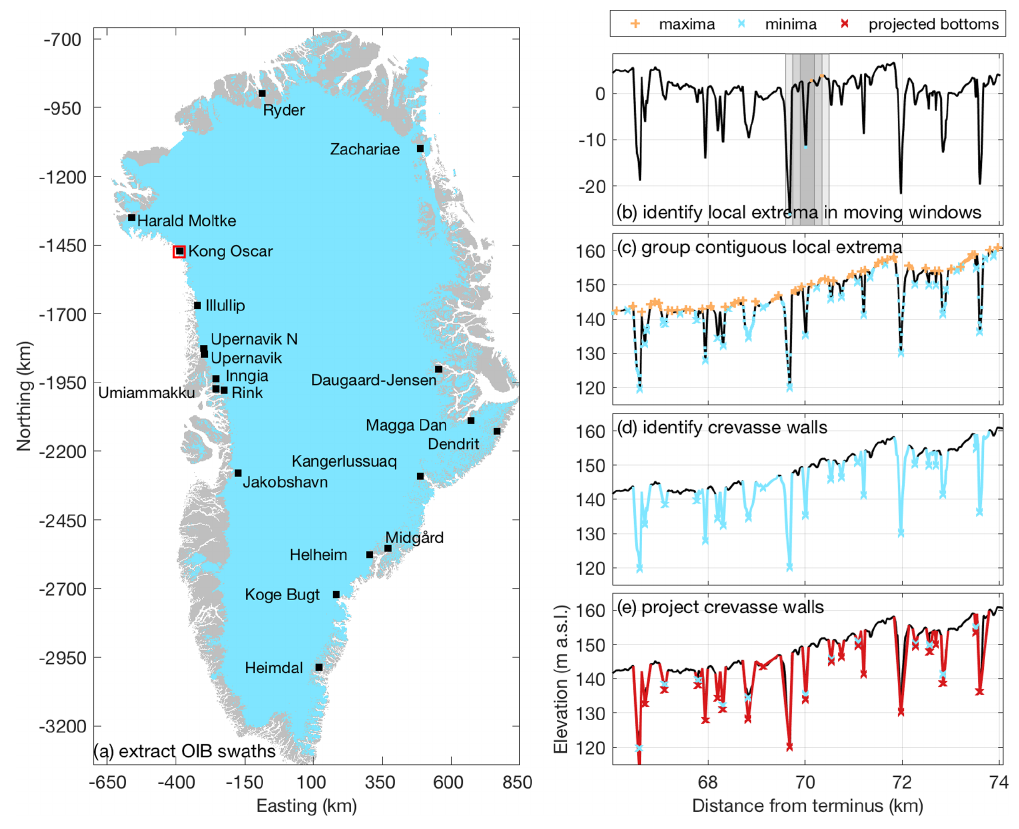
Figure 1. Map of glacier locations and example of the crevasse depth estimation approach applied to the elevation data for each glacier. (a) Operation IceBridge transects (black squares) overlain on the Greenland Ice Mapping Project ice mask (light blue) and land mask (gray). Glacier names are from Bjork et al. (2015). The red box highlights the location of the profile in panels (b) – (e) . (b) Moving window approach to find local extrema. The nested search windows (gray shading) and local extrema (colored points) overlain on the detrended portion of the profile. Local extrema (blue dots) were filtered to (c) isolate crevasse bottoms (blue x’s) and top edges (orange + ’s), (d) locate steeply sloped crevasse walls (blue lines), and (e) project wall slopes to